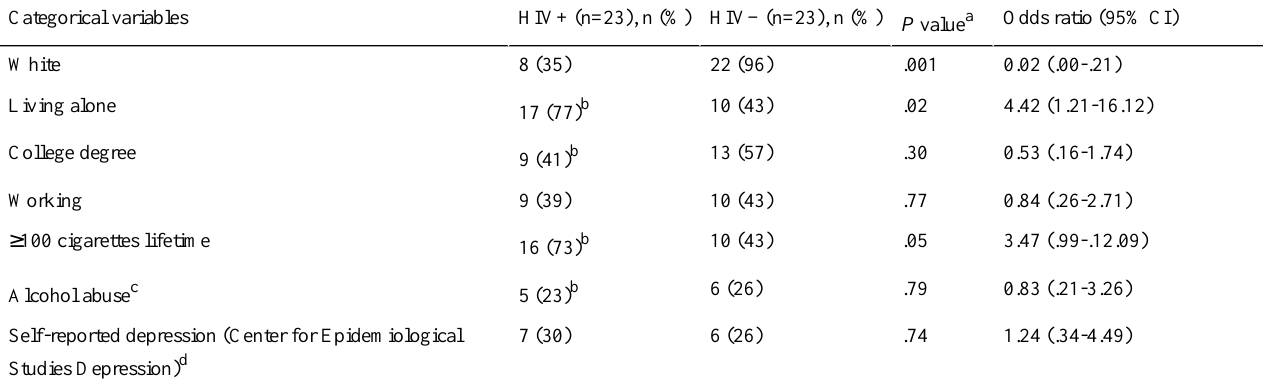
Table 2. The baseline characteristics of the study participants (categorical